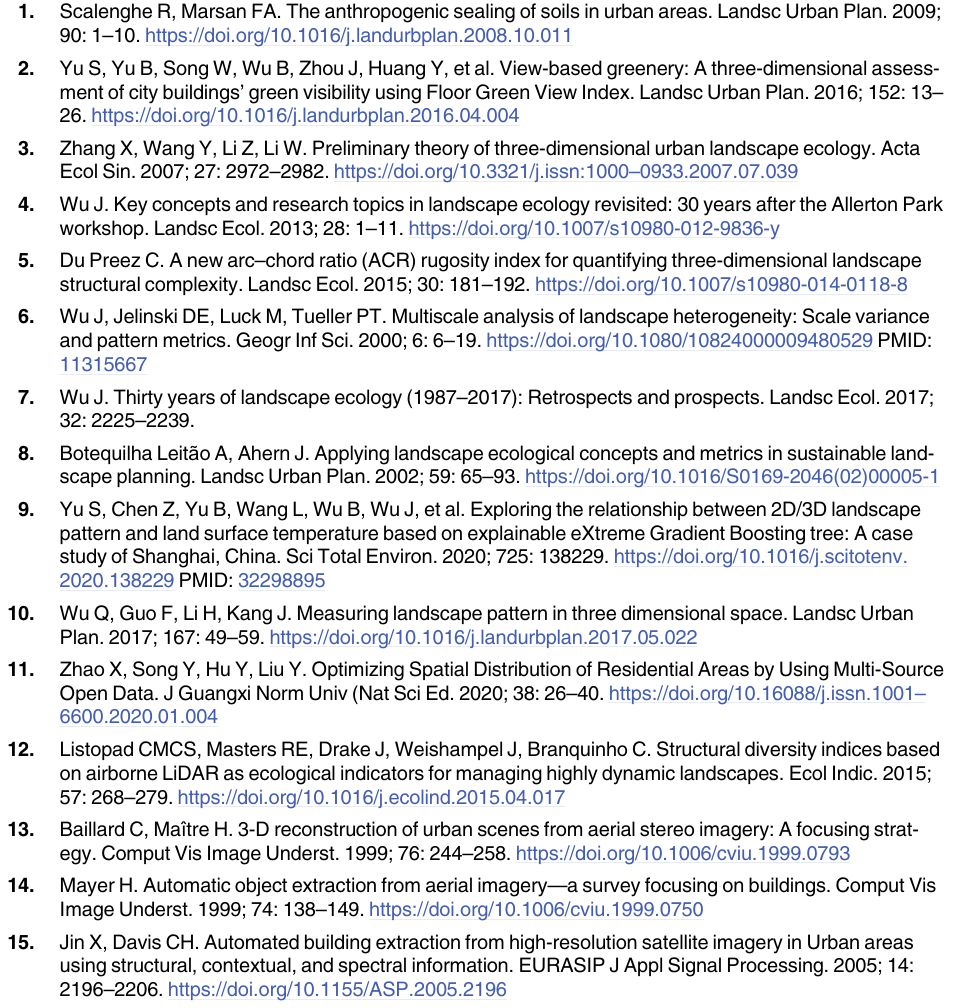
S1 Table. Data of 3-D architectural landscape metrics for